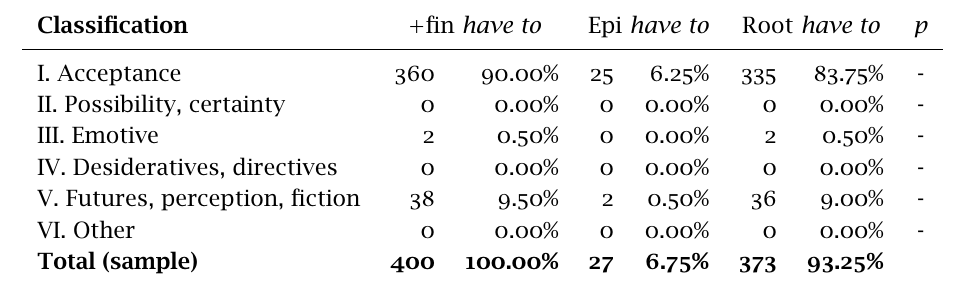
Distribution of have to in finite complements of attitude verbs: - p > 0 . 05 , Fisher’s exact test. Compares the distribution of epistemic and root have to in each class to the distribution of this semi-modal in a random sample of 400 matrix declaratives ( 41 epistemic, 359 root).